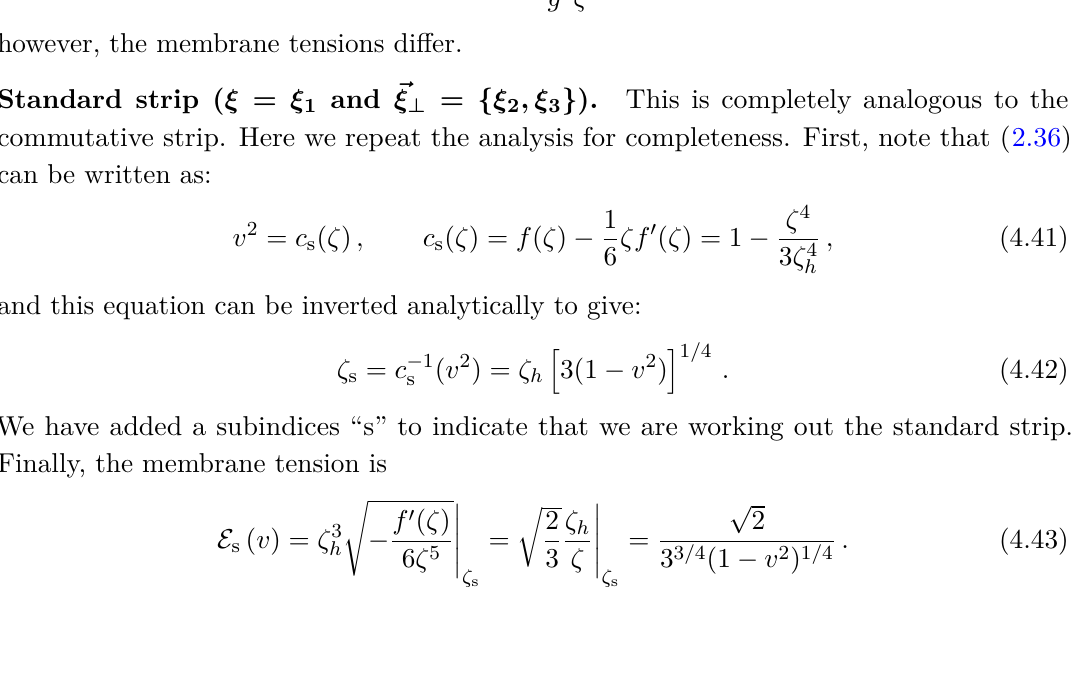
Figure 9 . Left: information velocity as a function of the entanglement fraction f for the commutative strip. We also show the limiting values, v (c) and orange, respectively. Right: information velocity for the non-commutative strip as a function of f for various values of ϑ ∈ { 0 , 1 / 2 , 1 , 2 , 5 , 10 } , from bottom to top,